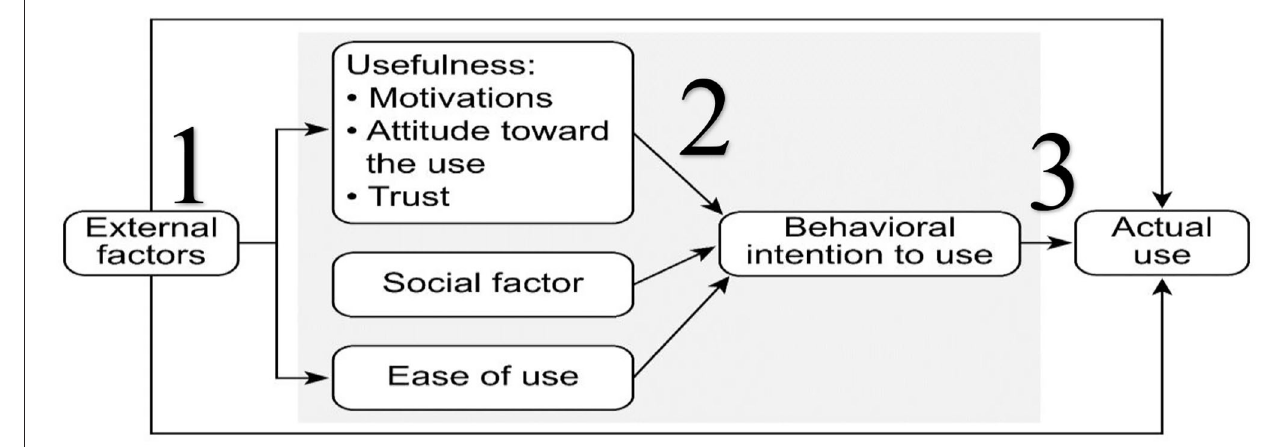
FIGURE 1 | Model of theory.